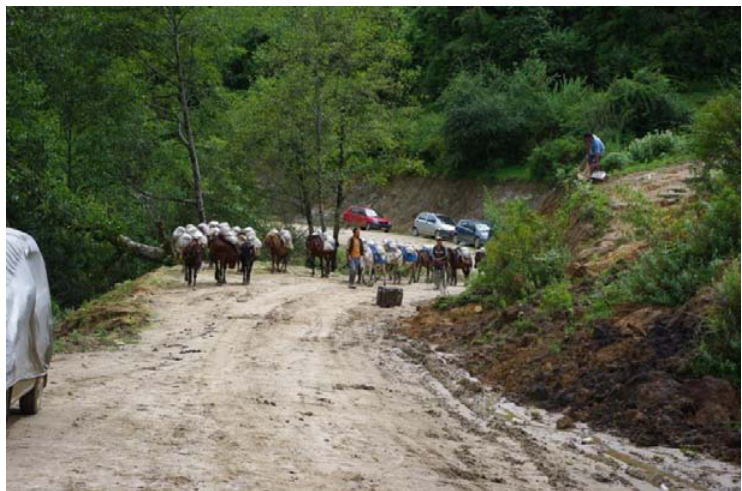
Figure 11. Transitional trailhead at Gayza, 2009.